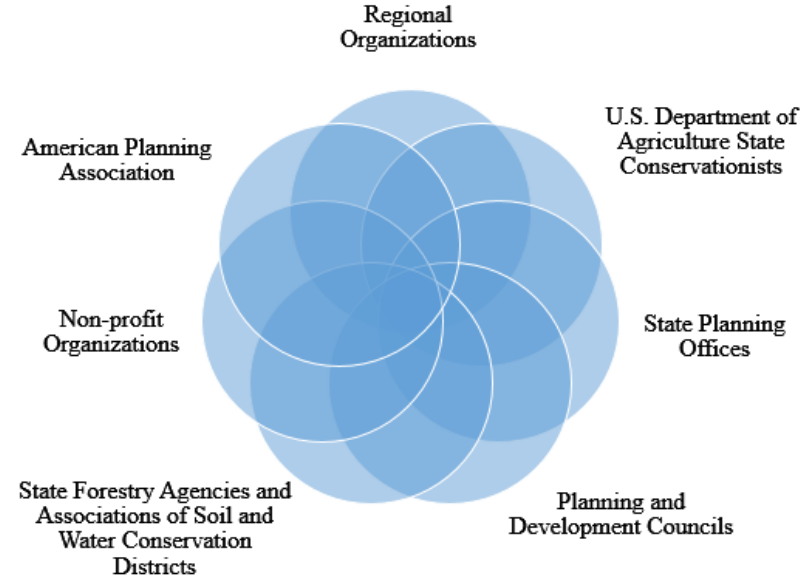
Figure 4. Organization types within the Potomac basin that have existing relationships with land use